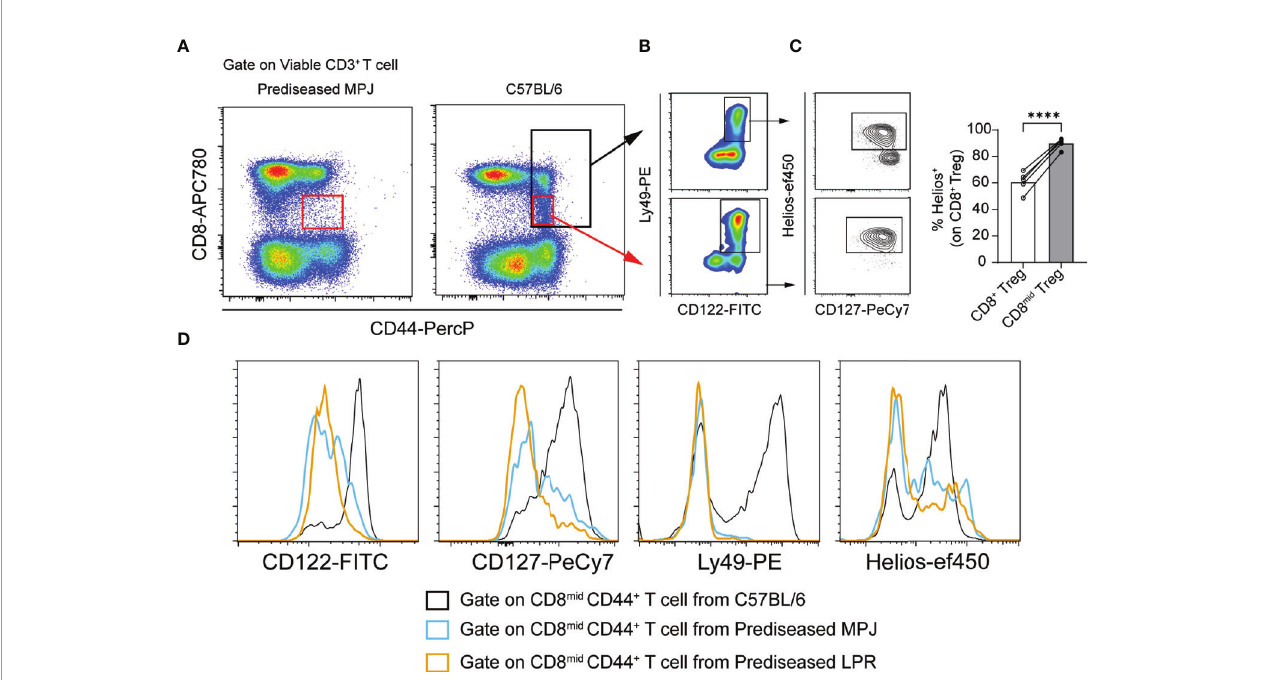
FIGURE 5 | Phenotypic analysis of CD8 mid CD44 + populations in prediseased MPJ and LPR mice. (A) Representative fl ow cytometry plots pregated on viable CD3 + T cell from prediseased MPJ (left) and C57BL/6 mice (right). (B) Representative fl ow cytometry plots of CD8 + CD44 + and CD8 mid CD44 + gates from C57BL/6 mice and their Treg phenotype. (C) Percentage of Helios + cells among CD8 + and CD8 mid Tregs. The data represent the mean values. (D) Representative histograms pregated on CD8 mid CD44 + T cells from C57BL/6 (black), prediseased MPJ (blue), and prediseased LPR mice (orange): ****P < 0.0001 by a paired Student t-test. Each point represents a single animal (C57BL/6, n =